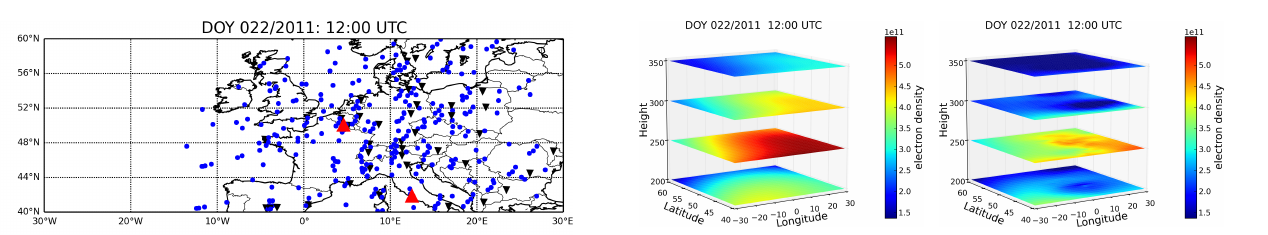
Figure 3. Typical measurement geometry over a part of Europe for DOY 22 (2011) using the IGS ground-station GNSS Network: IGS ground-stations (black triangles), ionospheric piercing points of the STEC measurements (blue circles). The ionosondes RO041 and DB049 (red triangles) are used for validation.